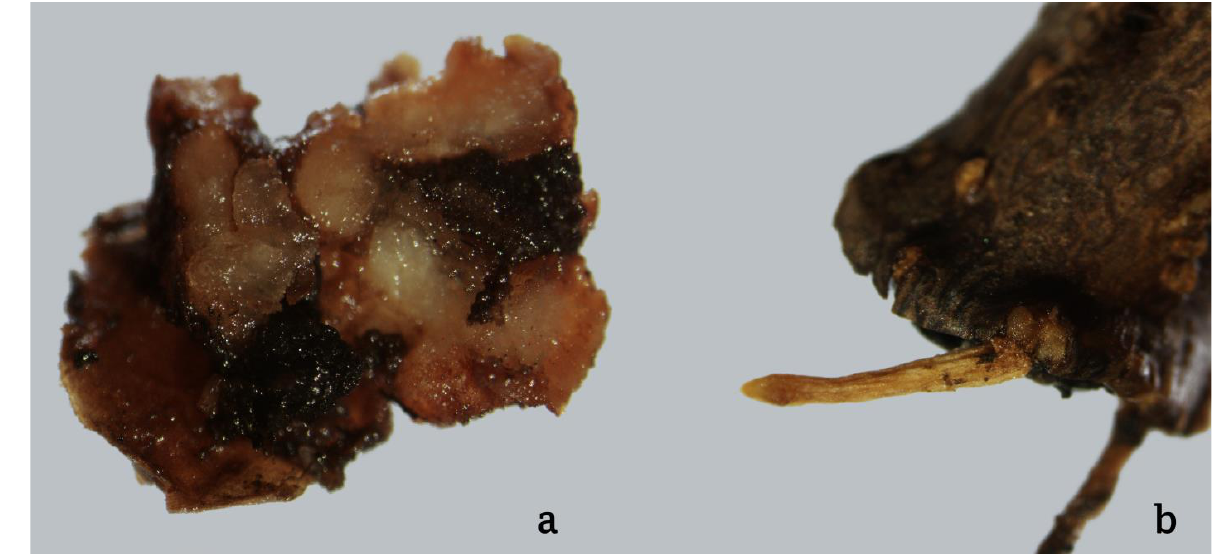
Table 1. Callused, rooted and unrooted cutting (%) at 70 DAC in P. x fraseri ‘Red Robin’ influenced by rooting promoters concentration (RPC). Figure 1 is a microscope image: we can see, on the left (a), the production of callous tissue in the G2 treated cutting; on the right (b), the adventitious root in the R1 treated Cuttings (%) cutting. Table 2 shows the callused and rooted cutting percentage at 100 and 240 DAC. At RPC 100 DAC, the greatest callused cutting percentage values were obtained in the untreated Callused Rooted control and Goteo ® at the highest dose. The R1 application resulted in 51% fewer callused cuttings compared to the control; the same trend was found at 240 DAC. Furthermore, K3 and G3 showed a lower production of callused cuttings, compared to the corresponding lower dose of the same biostimulant (K3: 11.3%; G3: 10.3%; K2: 18.0%; G2: 15.3%). The same Table 2 shows that, at 100 and 240 DAC, the percentage of rooted cuttings treated under R1 was statistically the highest (25% at 100 DAC and 34.3% at 240 DAC), with an increase of 15.5% compared to the control at 240 DAC. At 100 DAC, treatments with bi- ostimulants showed the lowest values of rooting compared to IBA. At 240 DAC, the worst results were obtained by both biostimulant treatments at the highest doses, with no sta- tistically significant differences between them (K3 = 21.3% and G3 = 20.7%).